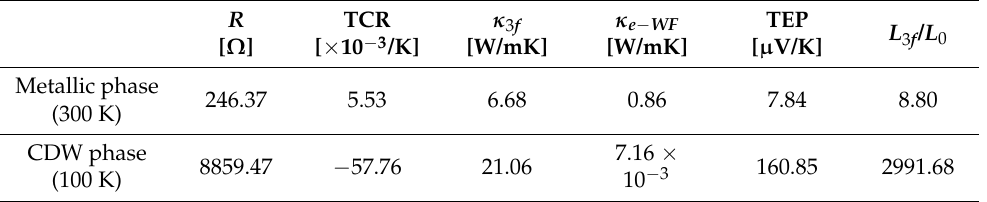
Table 1. Whole measurement results from single TaS 3 fiber.